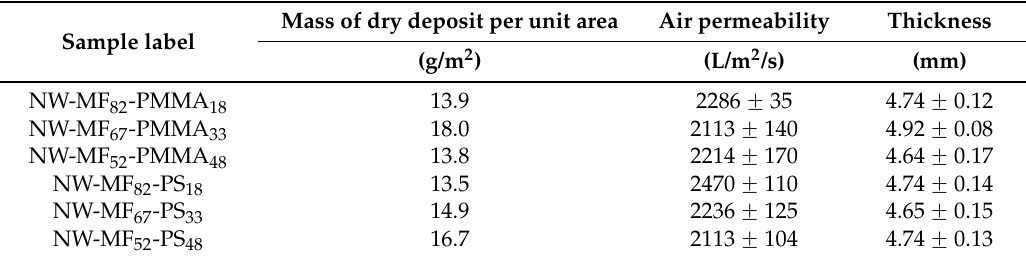
Table 5. Physical properties of the impregnated nonwoven samples.